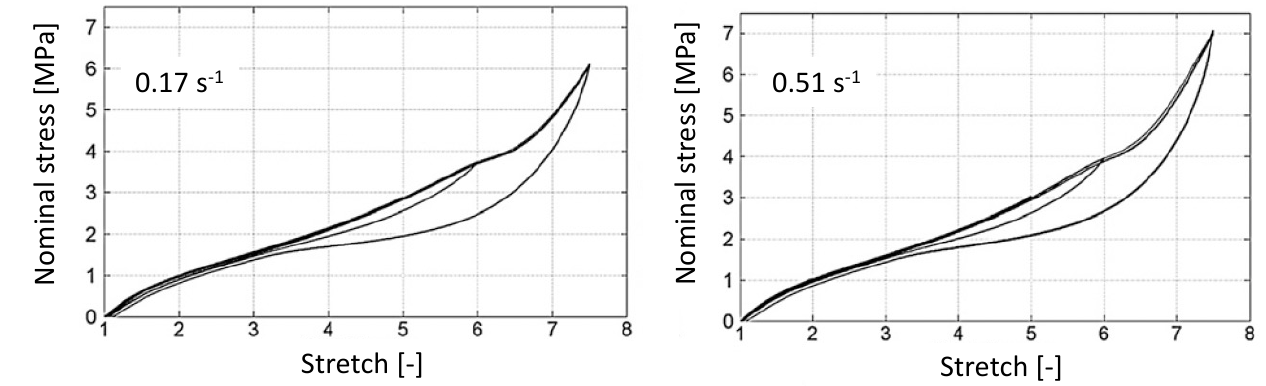
0.17 s − 1 (on the left hand side) and ±